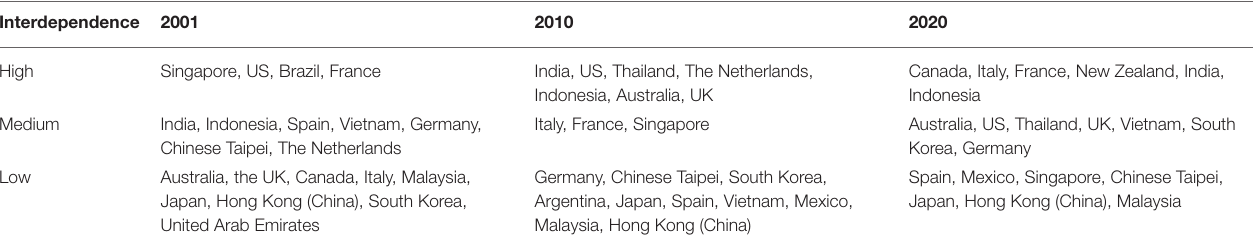
TABLE 7 | Ranking of China’s top 20 trading partners in trade of TCM products by interdependence in 2001, 2010, and 2020. Interdependence 2001